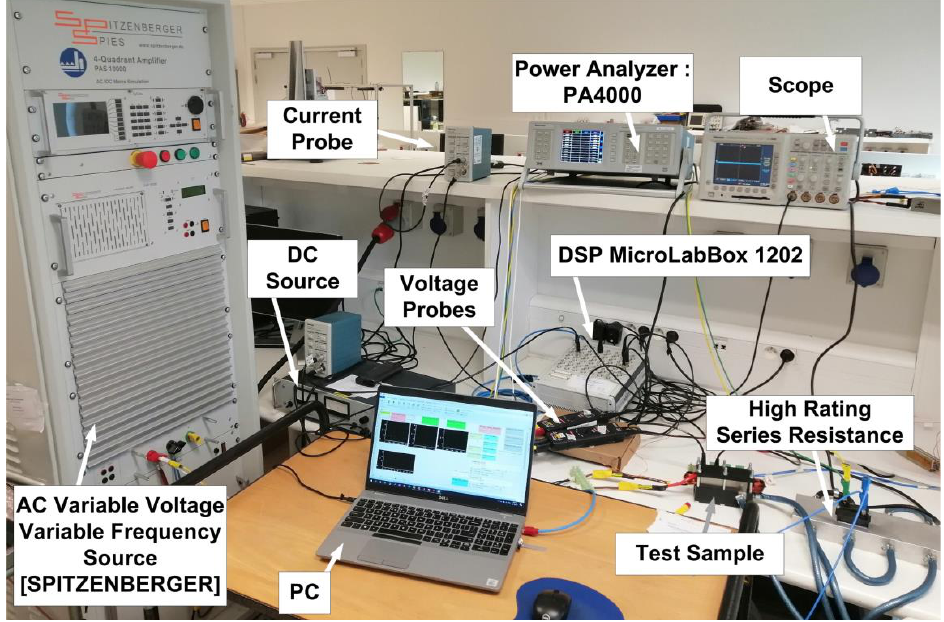
Figure 12. Test setup for the AC losses of the coil samples.